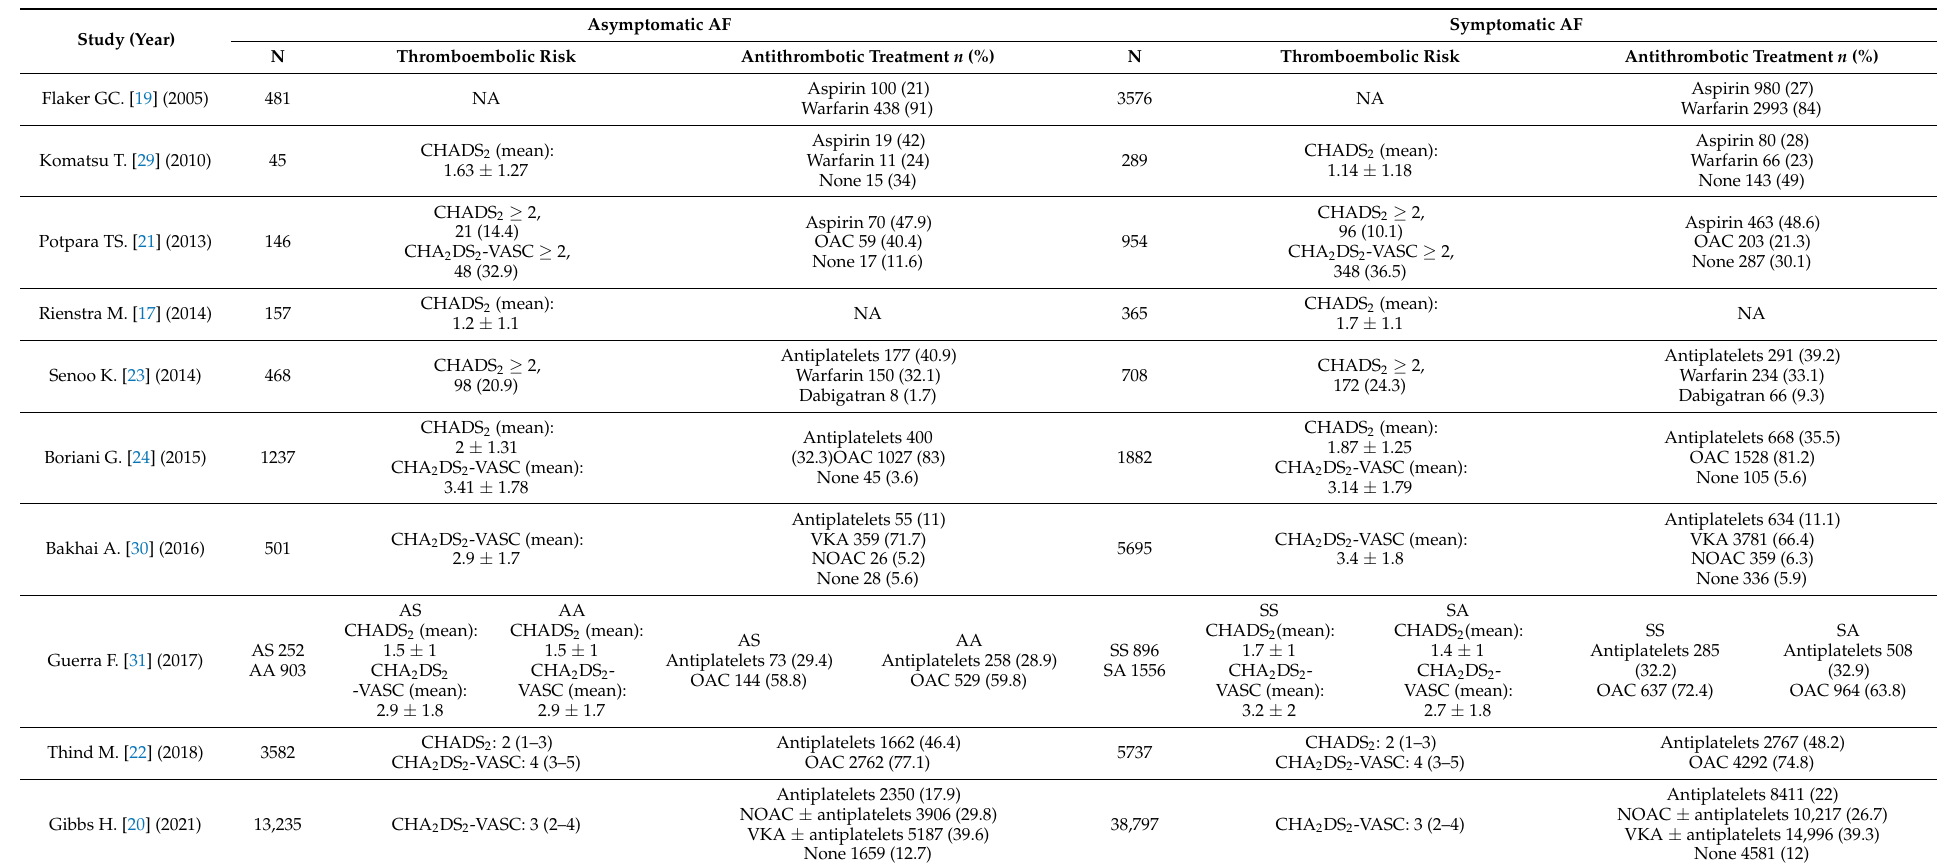
Table 2. Thromboembolic risk and anti-thrombotic treatment in asymptomatic and symptomatic AF